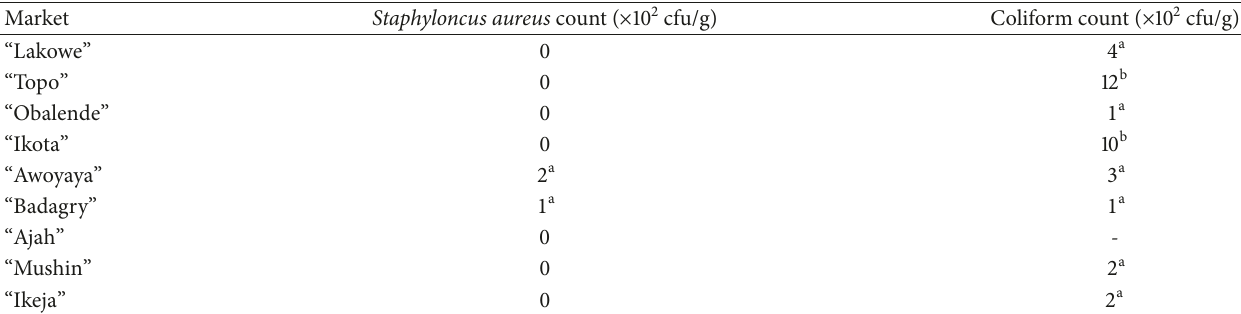
Table 2: Incidence of pathogenic bacteria in roasted cashew nuts from Lagos State, Nigeria.